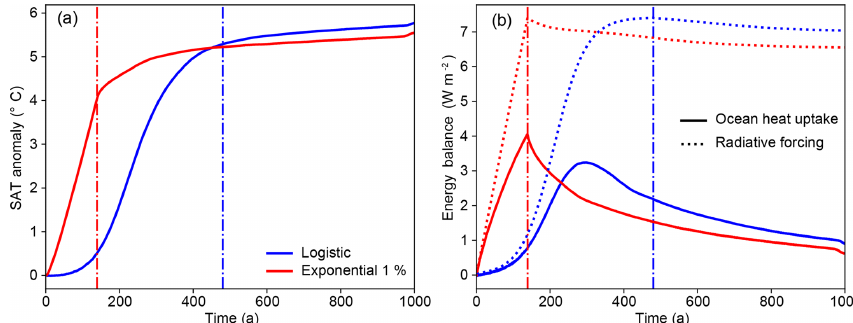
Figure 11. (a) Evolution of global surface air temperature (SAT) anomaly during the transient run and zero emission phase of logistic and 1% 4 × CO 2 experiments. (b) Ocean heat uptake (solid lines) and radiative forcing (dashed lines) for each experiment. Vertical dash–dot lines mark transition from prescribed atmospheric CO 2 concentration to zero emissions with free-evolving atmospheric CO 2 concentrations. Note ocean heat uptake peaks before emissions cease under the logistic experiment.